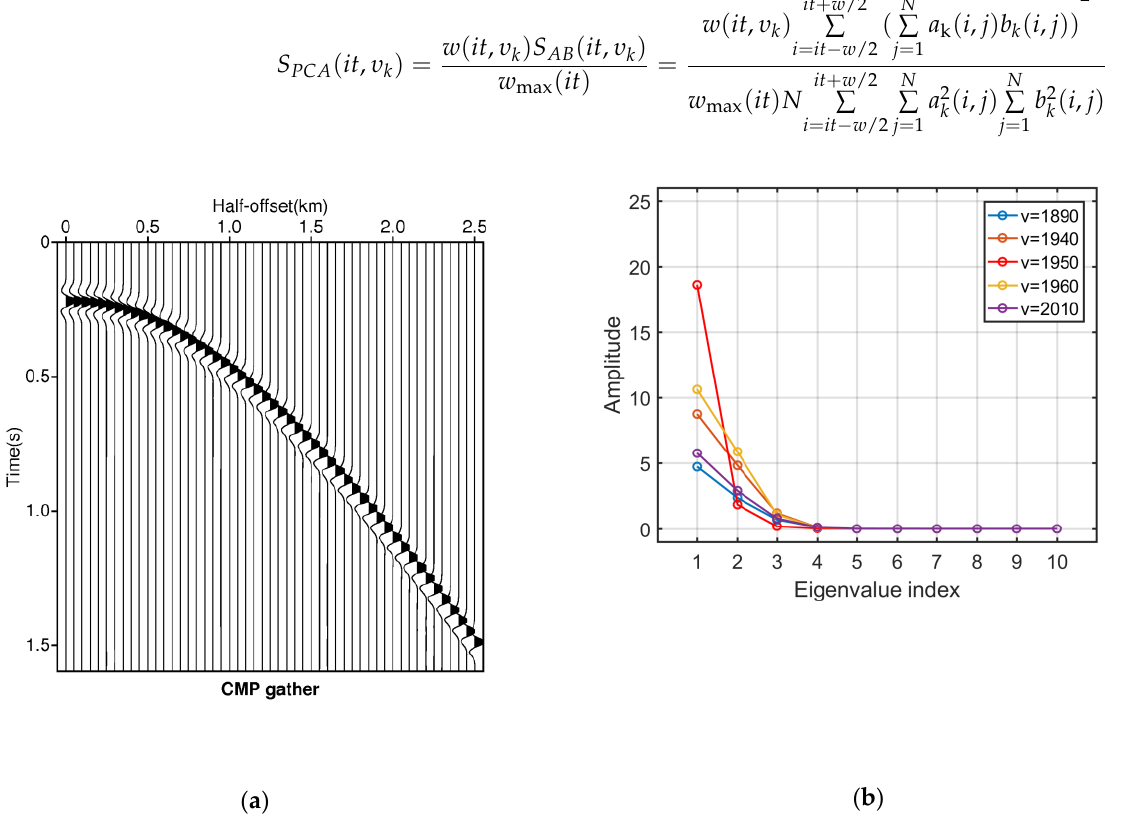
Figure 1. A seismic event at time 0.24 s with a velocity υ = 1950 m/s. ( a ) CMP gather and ( b ) The corresponding principal components (eigenvalues) of the NMO-corrected CMP gathers with different scanning velocities.